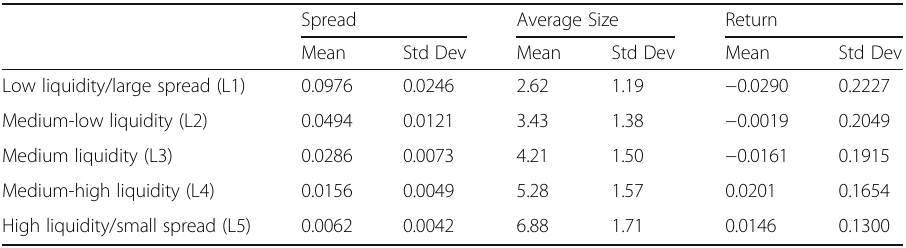
Table 6 Summary Statistics of Different Levels of Liquidity